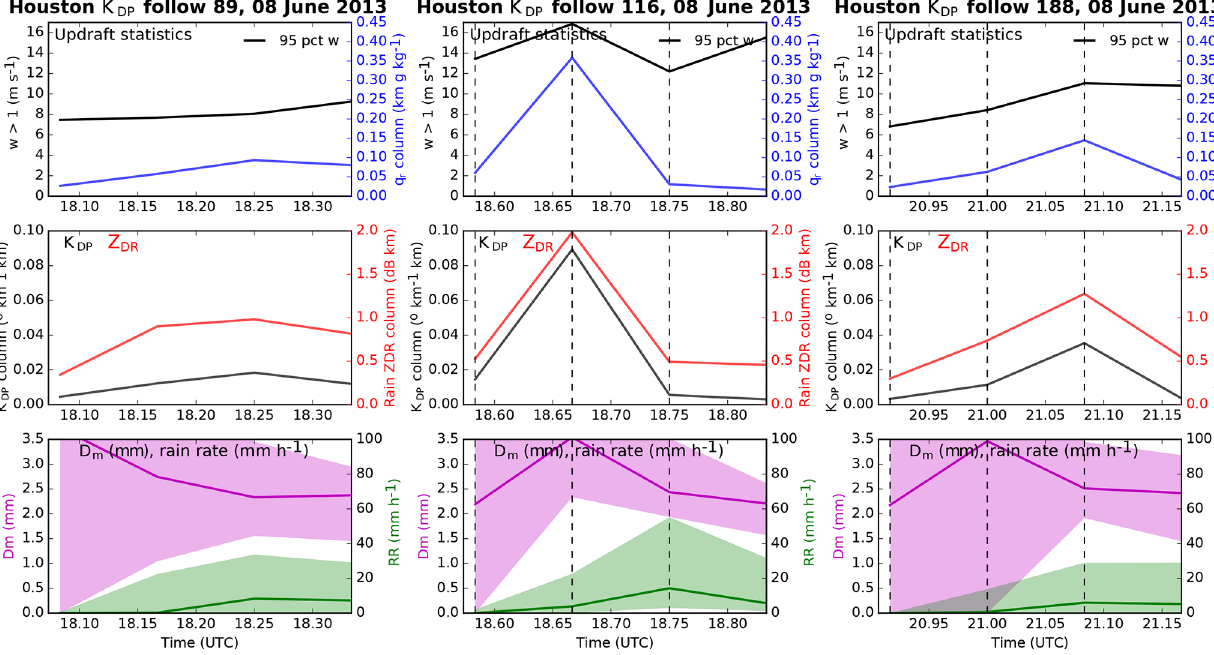
Figure 7. Time series from three K DP columns tracked from NU-WRF simulation output show (top-to-bottom) updraft strength, q r , K DP , and Z DR column strengths (calculated following Eq. 1), and rain rate and drop D m and N w . Updraft and rain statistics collected within 2.5km of the tracked K DP column center. Vertical dashed lines indicate times of columns 116 and 188 cross sections shown in Figs. 8 and